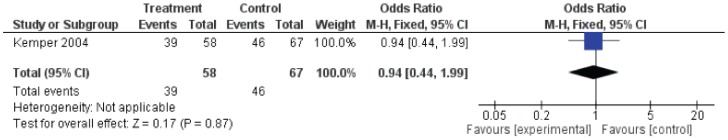
Analysis of pruritus (pimecrolimus vs tacrolimus).